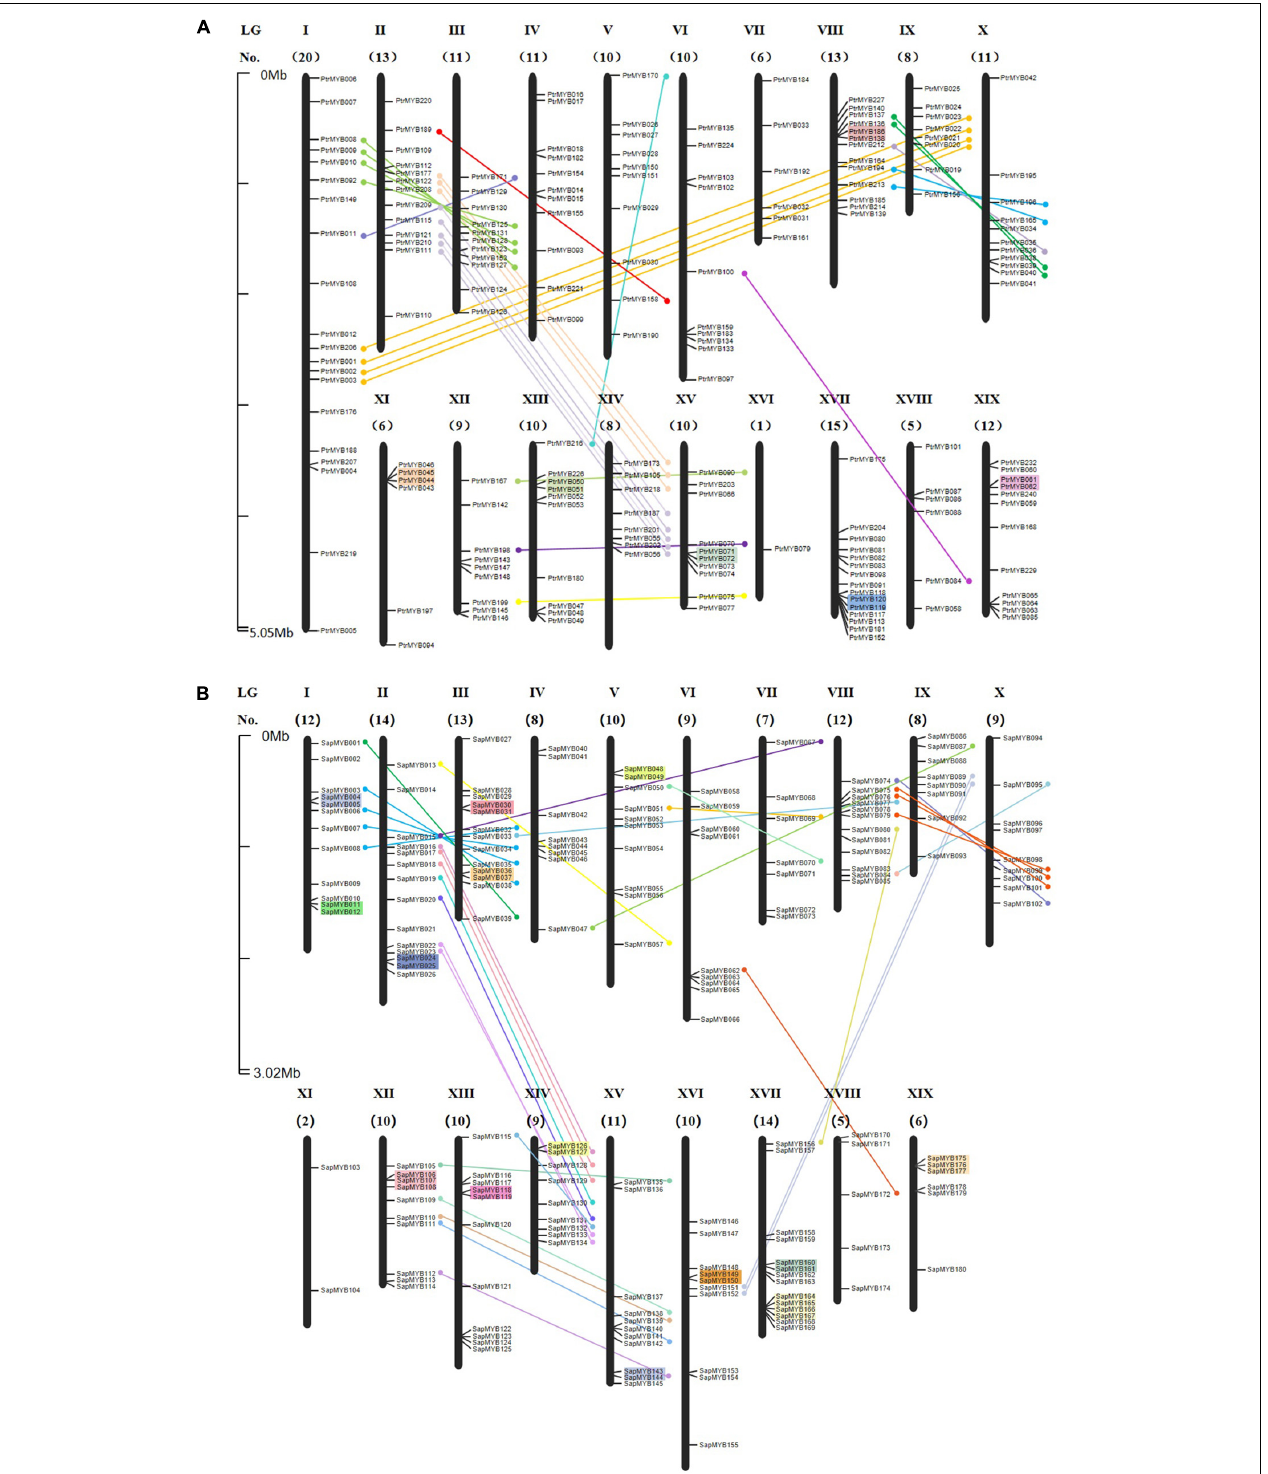
FIGURE 1 | Chromosomal locations for R2R3 MYB genes of poplar and willow. (A) Poplar and (B) willow R2R3 MYB genes were mapped to their corresponding chromosomes based on the published genome information of the poplar and willow. Chromosome numbers are displayed above each chromosome. The numbers below indicate the number of R2R3 MYB genes on each chromosome. The scale is in megabases (Mb). Each gene is named according to the order of its corresponding location on the chromosome. Paralogous genes are indicated by lines, genes contained in the segmental duplicated homologous blocks are connected by lines of the same color, and tandemly duplicated genes are indicated by colored